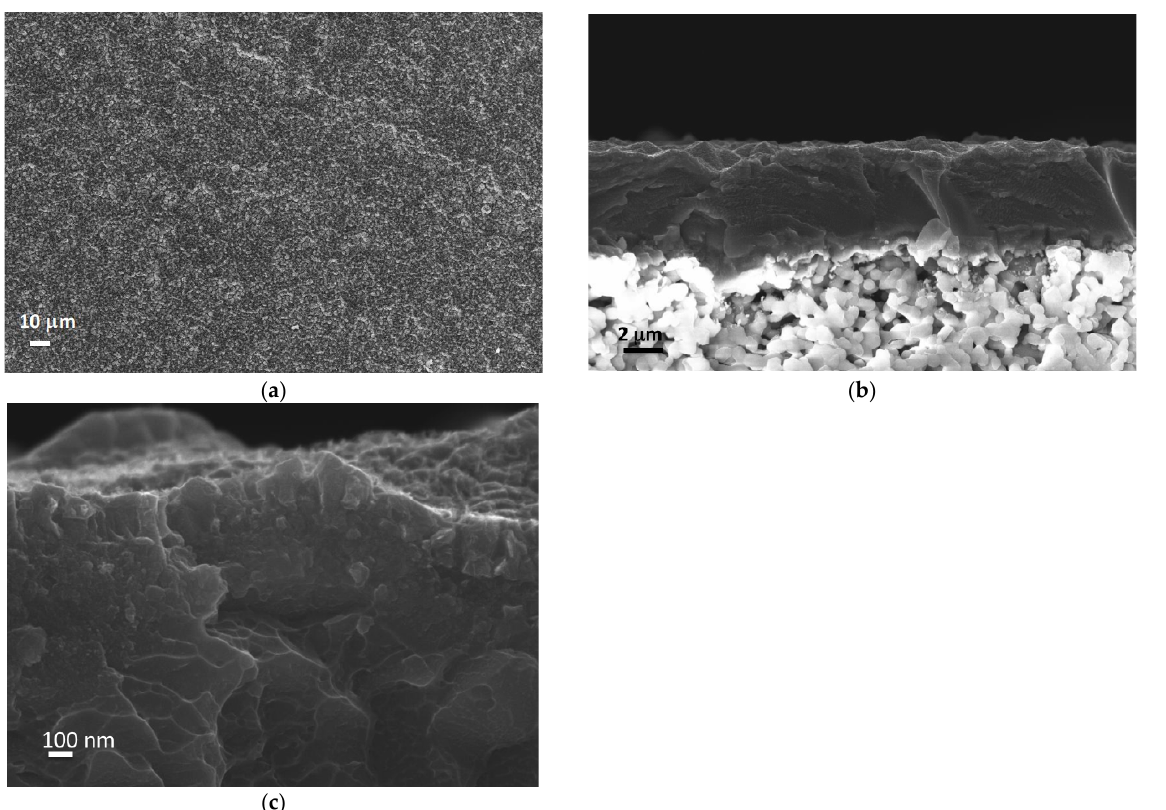
Figure 6. Hydrogen permeability measured at 350 °C for some membranes as a function of VEC.